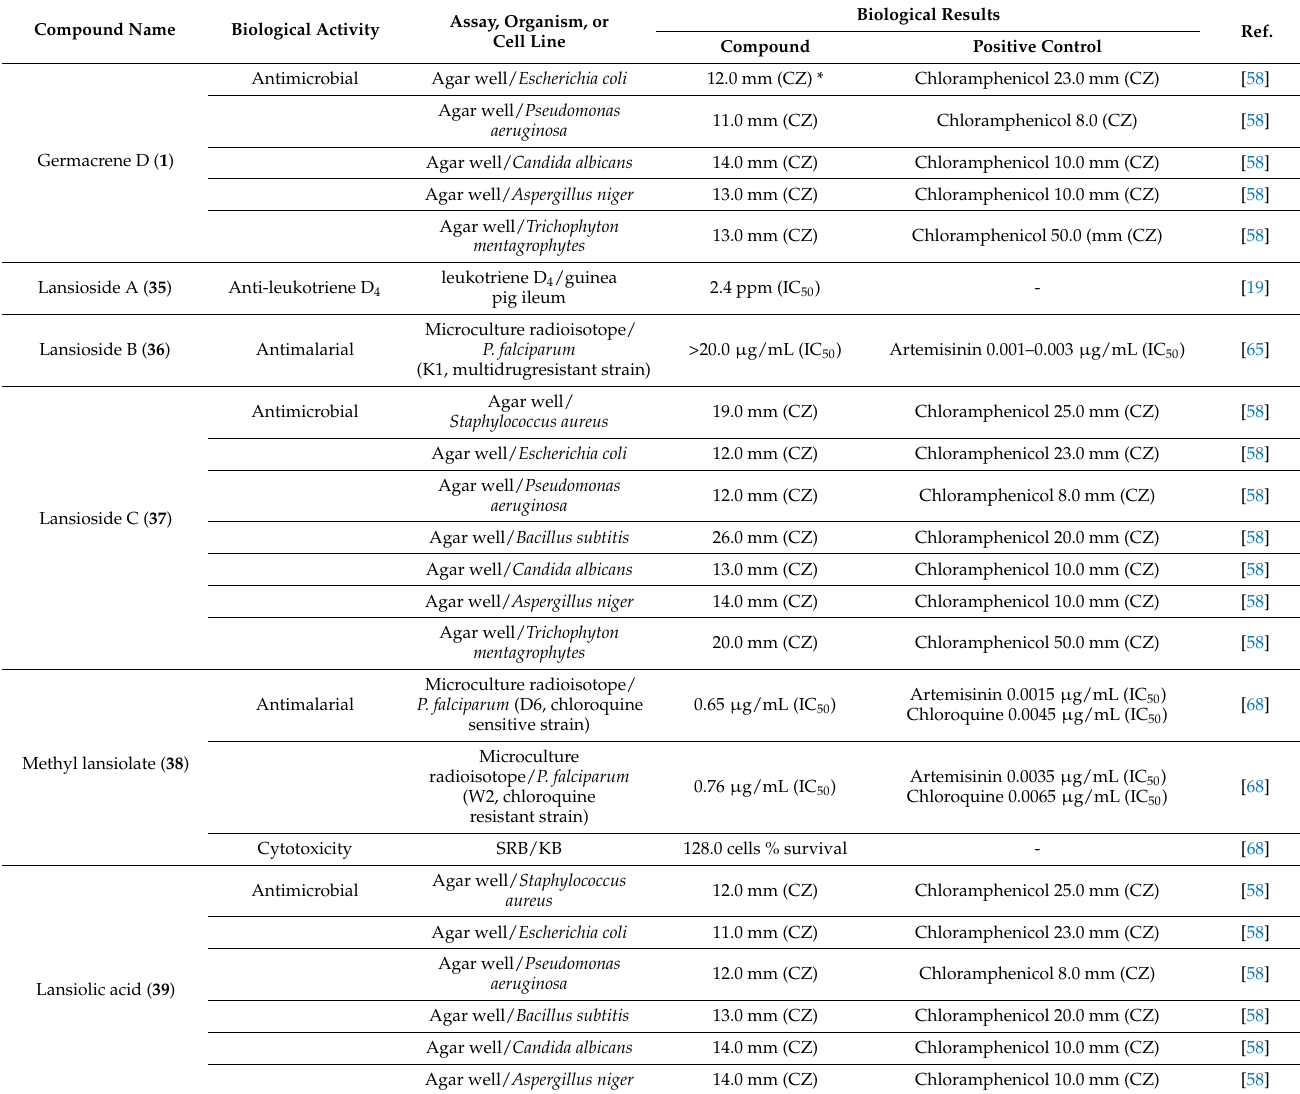
Table 5. Biological activity of reported phytoconstituents from Lansium domesticum